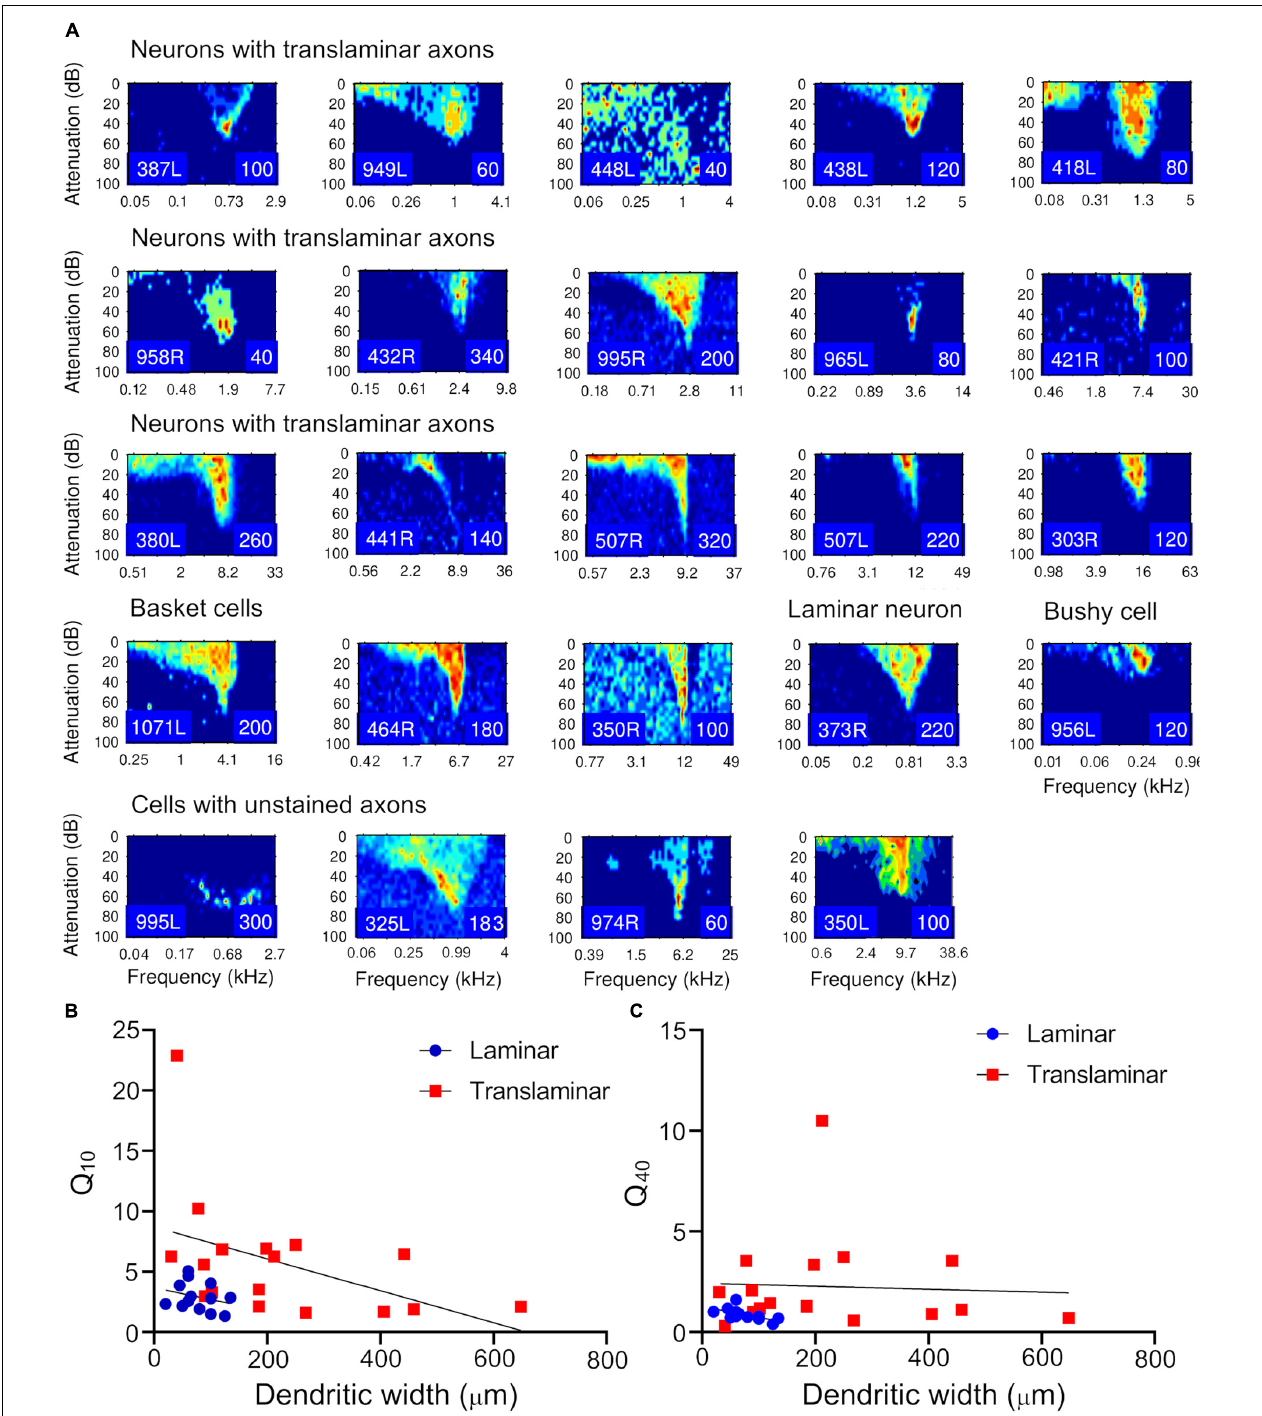
FIGURE 12 | Frequency response areas for the filled cells. (A) The arrangement of panels follows the tonotopic order in Table 1 for each class. The response areas are normalized on a temperature scale from blue (zero response) to red (maximum response). The number in the bottom right hand corner of each panel for this and Supplementary Figure 6 indicates the maximum firing rate to which the plot is scaled (spikes/s). (B) The relationship between the sharpness of tuning at 10 dB above threshold (Q 10 ) and the width of the dendritic tree across the fibrodendritic lamina was plotted separately for the cells with translaminar axons (including the basket cells) in this study (red squares) and the cells with laminar axons from this and our previous study (blue circles). The linear regression line was also plotted for each group. (C) The same relationship was also shown by plotting the sharpness of tuning at 40 dB above threshold (Q 40 ) for the two groups and again showing the linear regression line.